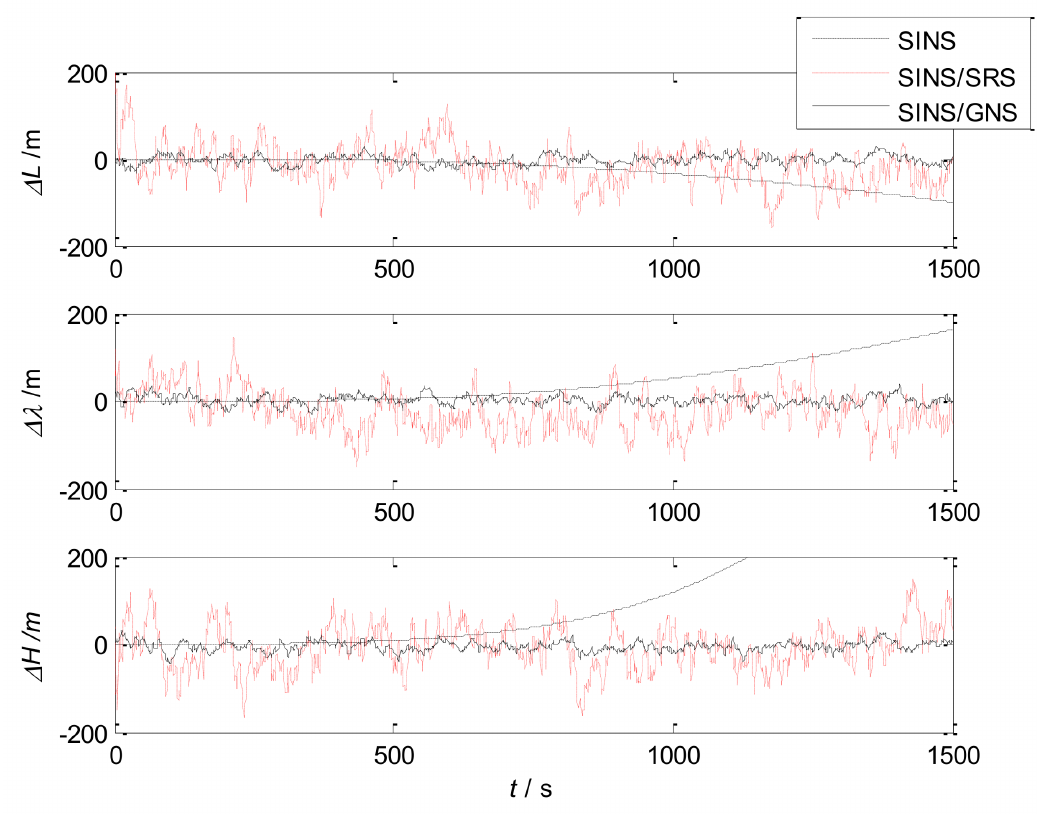
Figure 5. Position errors of the subsystems. Table 2. The error statistics of the